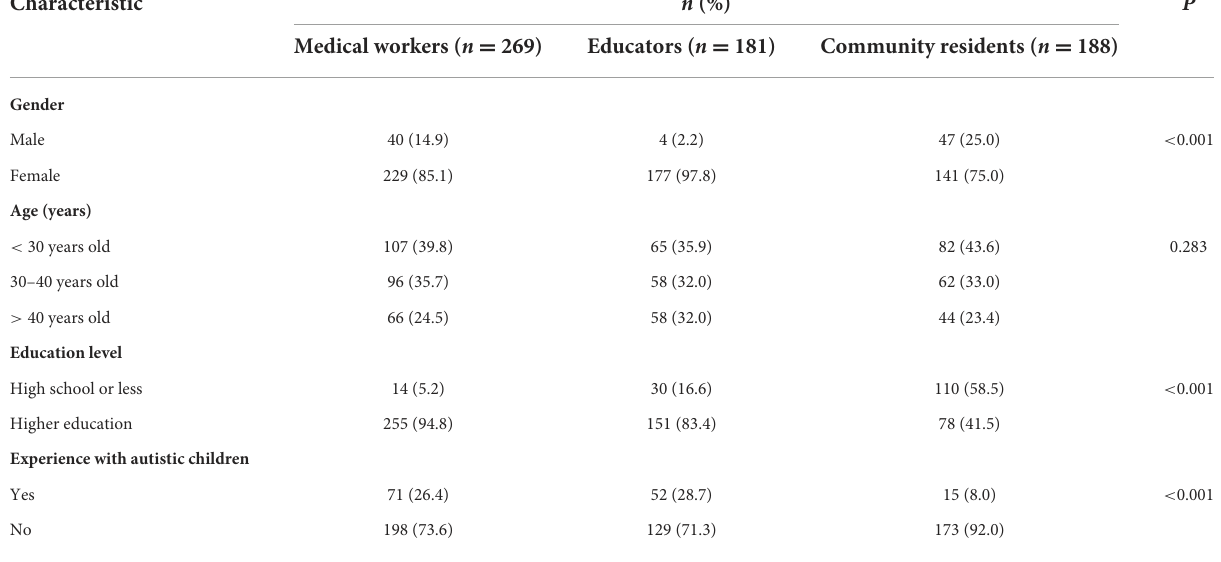
TABLE 1 Characteristics of the three groups ( N = 638).